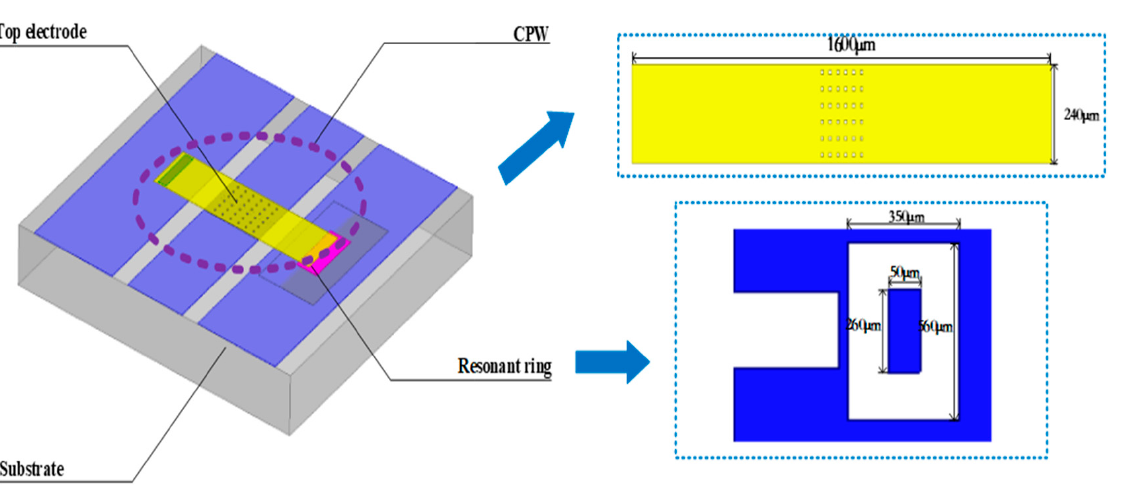
Figure 5. Simplified equivalent circuit.